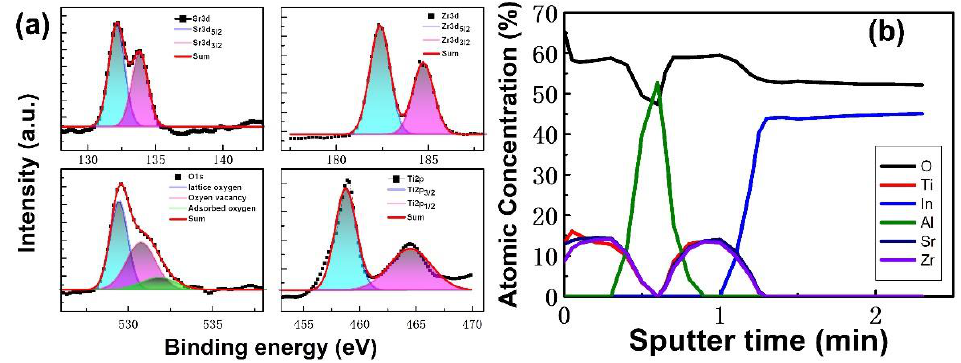
Figure 3. ( a ) High-resolution XPS spectra of Sr3d, Zr3d, Ti2p, and O1s of the SZT thin film. ( b ) Atomic concentrations of six elements in the SZT/Al/SZT tri-layered thin film with XPS depth profiling.